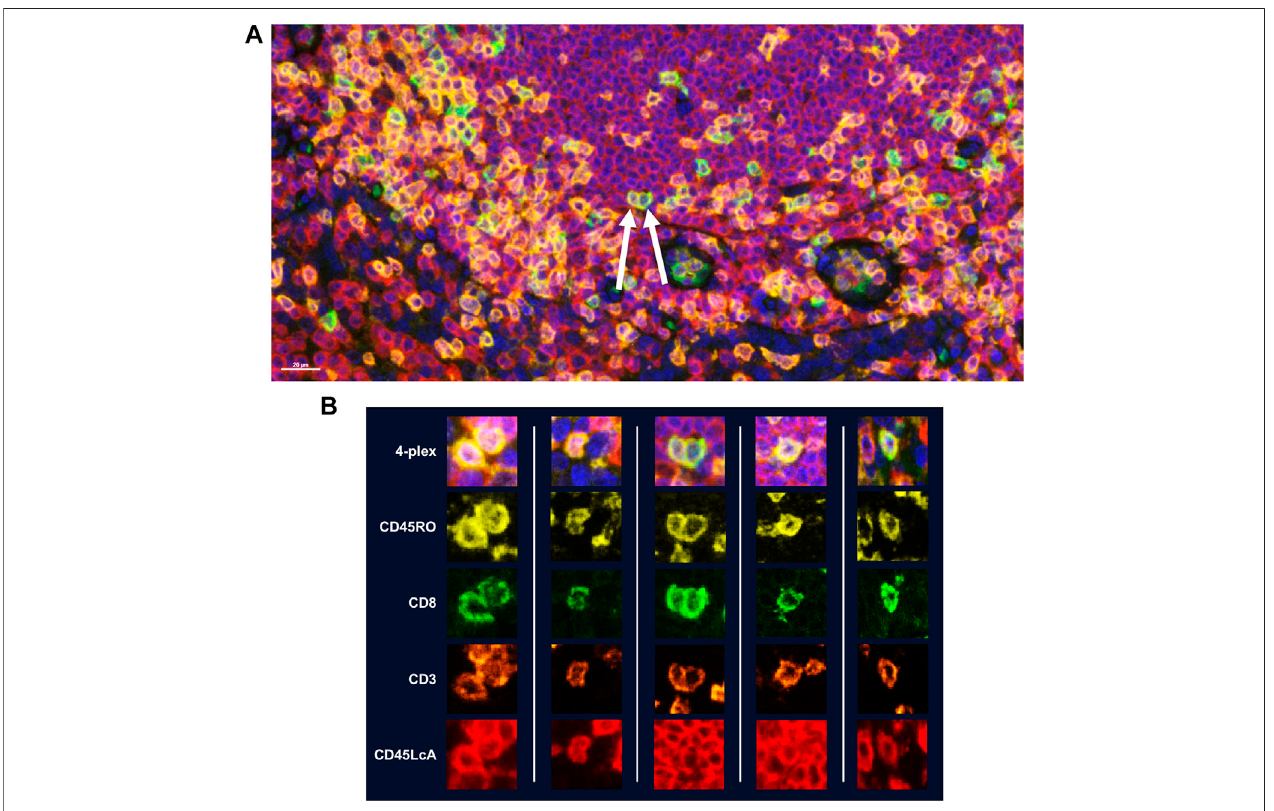
FIGURE5| AssessmentofTSAstaininginterference indetectionofmultiplemarkerswithinthesamecellular compartment. Fourmembranemarkerswerechosen forthisexperimentwhichareknowntohavesigni fi cantco-localizationwithoneanother:CD8(Opal520),CD3(Opal620),CD45RO(Opal570),andCD45LcA(Opal690). All reagents were double dispensed using the BOND RX and scanned using the Vectra Polaris. (A) Image with arrows indicates cells that display all four markers. (B) Additional representative images of cells displaying all four markers without any reduction in signal intensity demonstrating that TSA does not interfere with detection of three or more markers co-localized to the cell